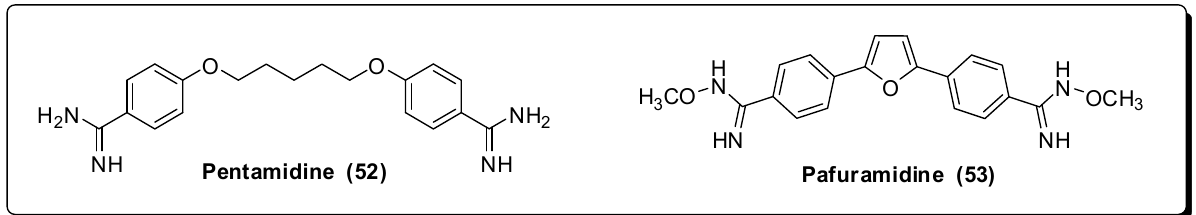
Figure 17. Compounds with antileishmanial activity.